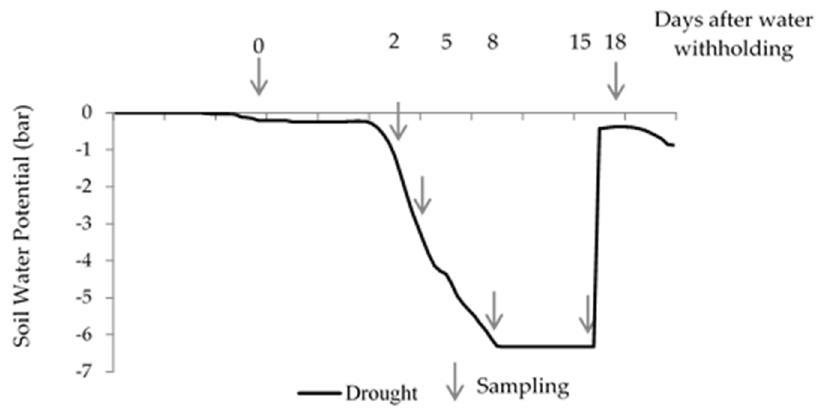
Figure 2. Variation of the soil water potential before, during, and after drought stress. Four weeks after planting, watering was withheld. Minus 6 MPa soil water potential was maintained for a week, and then plants were rewatered to initial soil water potential. Arrows indicate different time-points where measurements were taken.